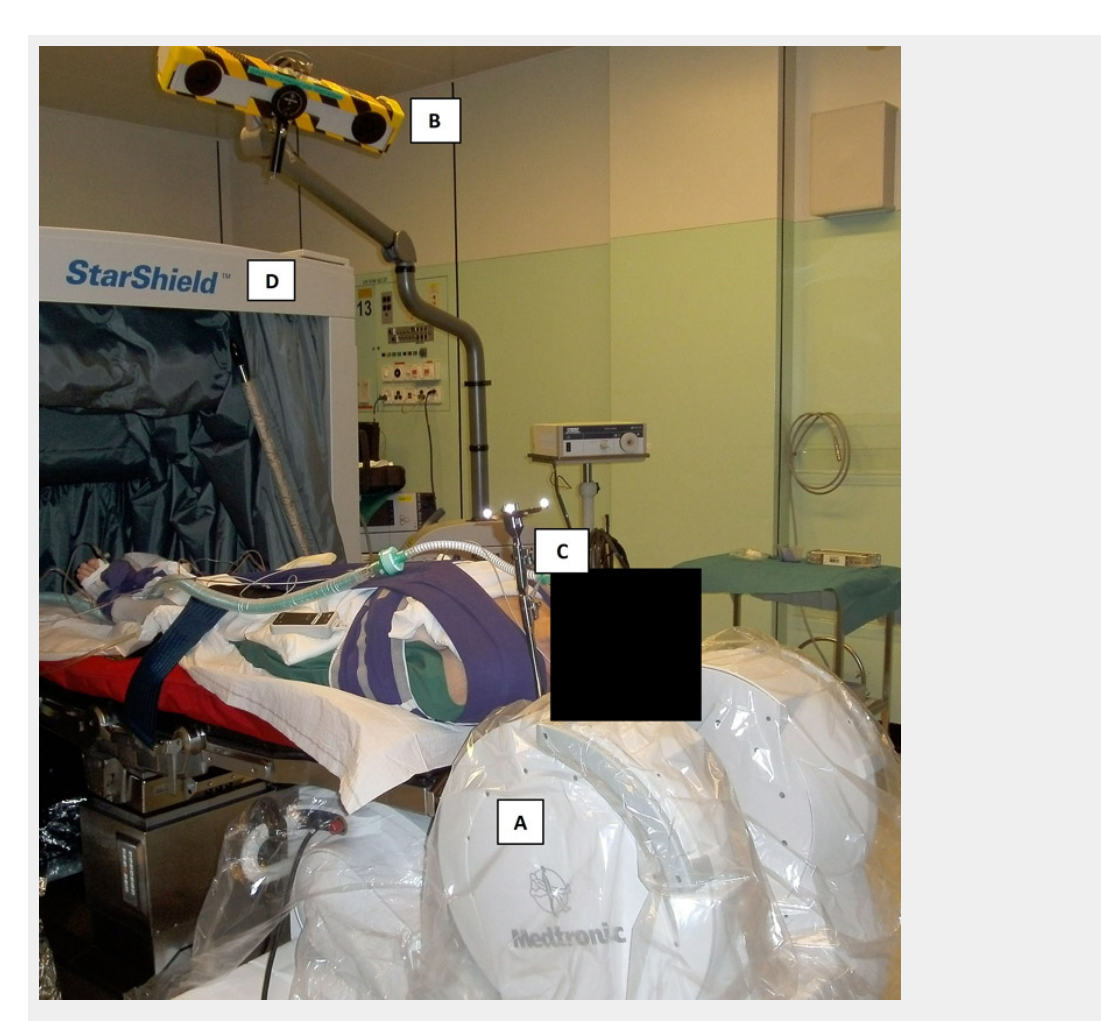
Setup for iMRI-guided transsphenoidal surgery. The patient is positioned in supine position with the head fixed in a MRI-compatible head clamp. Since the PoleStar ® device (A; Medtronic, Inc.) needs to be placed very close to the shoulders, gentle traction is applied by soft bandages. Two LED cameras (B) record the position of a tracking frame (C) which is fixed to the head clamp and referenced to the surface of the patient’s face for frameless stereotactic navigation by the StealthStation TREON ® system (Medtronic, Inc.). During the scans, the PoleStar ® device is moved into scanning position and the StarShield Portable RF Shield ® (D; Medtronic, Inc.) is closed. Thereby, electronic devices may remain turned on during scanning and there’s no need for full room radio frequency